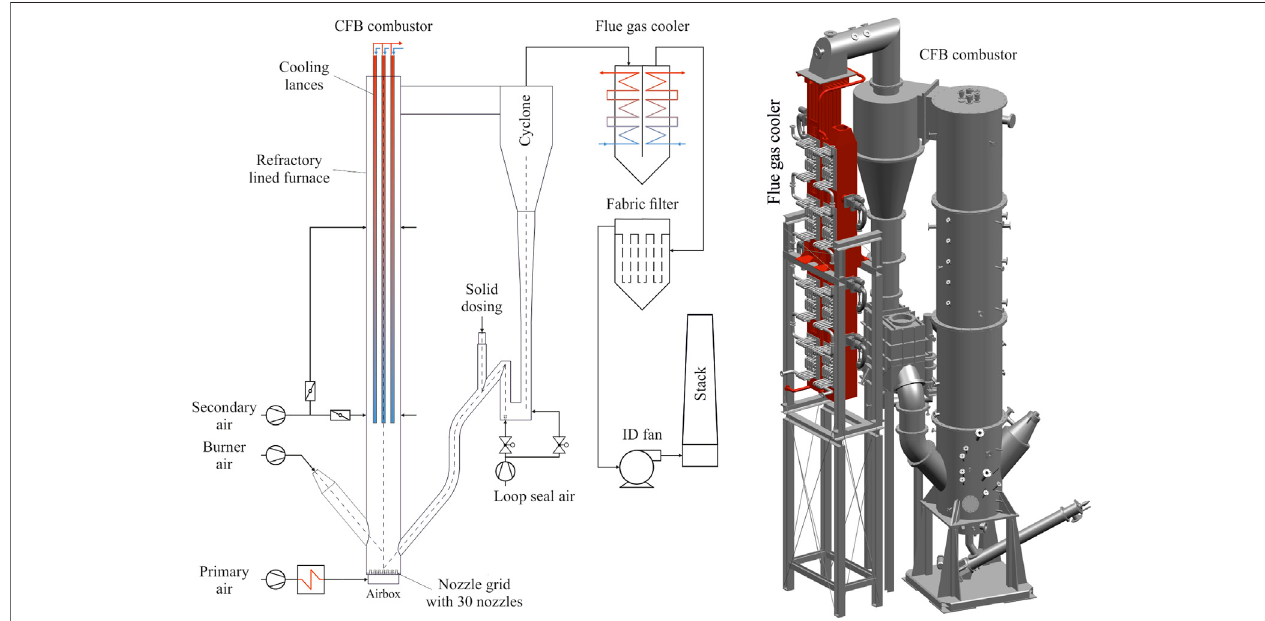
FIGURE 1 | Experimental setup – fl ow scheme of circulating fl uidized bed combustor and periphery.